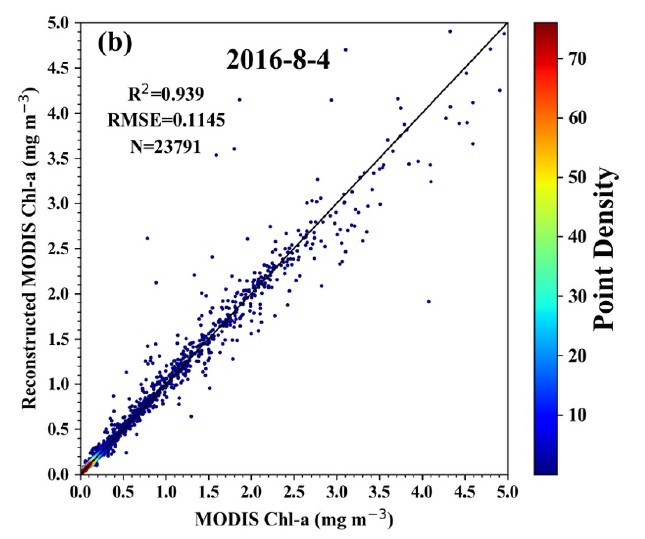
Figure 4. 1:1 scatter plots of the original MODIS Chl-a vs. reconstructed Chl-a by the grid-fill method on ( a ) the winter day (2016.2.2) and ( b ) the summer day (2016.8.4). The most important combinations of S-2A images, among the 597 cases, were chosen by utilizing the SVR-RFE method. Four high-ranked combinations were selected as the final variables, namely, B1/B3, B2/B3, B1/(B3+B4), and B2/(B3+B4). These selected predictors are a combination of bands 1 (Coastal aerosol), 2 (Blue), 3 (Green), and 4 (Red).